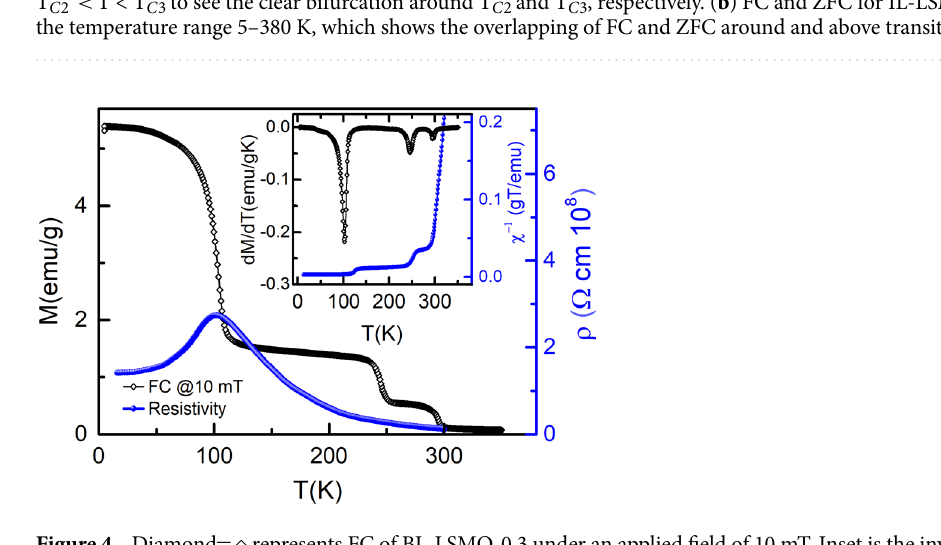
Figure 4. Diamond − ⋄ represents FC of BL-LSMO-0.3 under an applied field of 10 mT. Inset is the inverse of dc susceptibility showing three transitions at ≈ 101 K, ≈ 246 K, and ≈ 295 K corresponding to T C 1 , T C 2 , and T C 3 , respectively. circle −◦ represents the resistivity versus temperature plot of bilayer La 1.4 Sr 1.6 Mn 2 O 7 . Metal- insulator transition temperature (T MI ) is also 101